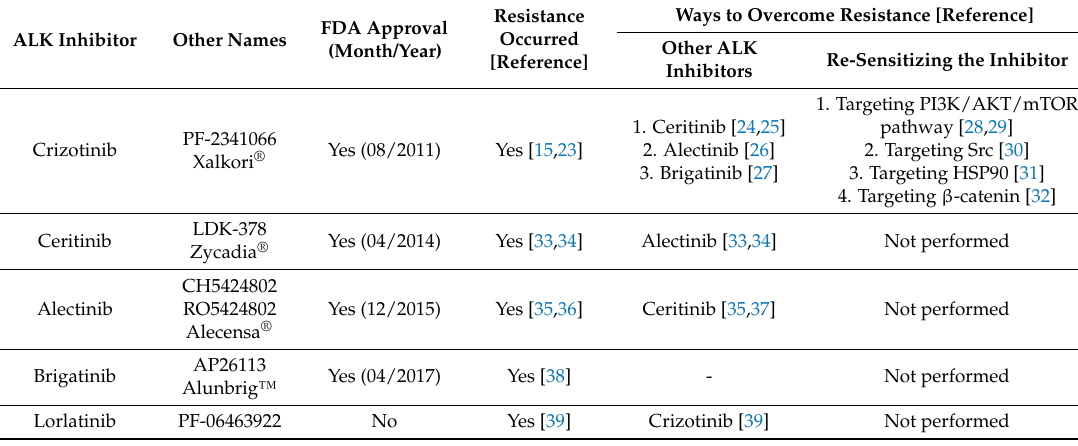
Table 1. Summary of first and next generation ALK inhibitors.